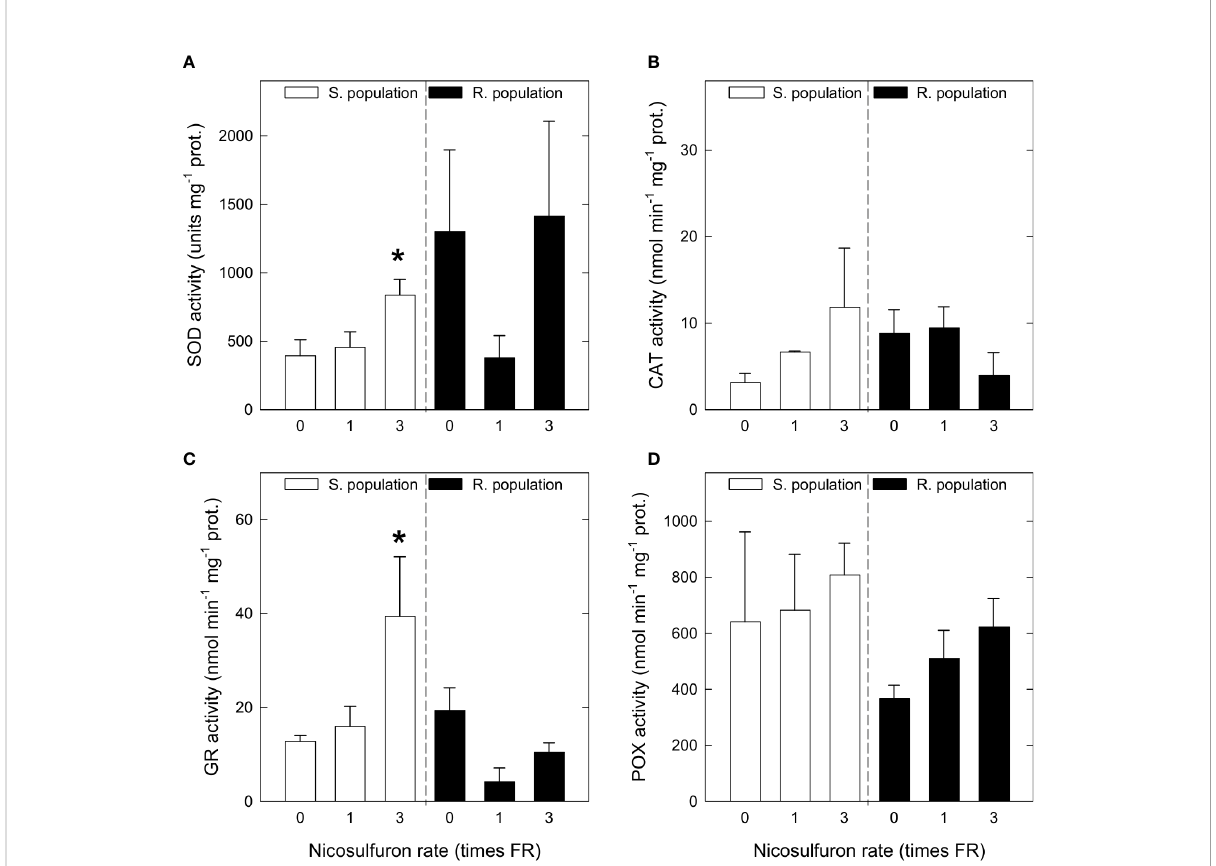
FIGURE 4 Superoxide dismutase (SOD) activity (A) , catalase (CAT) activity (B) , glutathione reductase (GR) activity (C) and peroxidases (POX) activity (D) in Amaranthus palmeri sensitive (S, white) and resistant (R, black) populations treated with different nicosulfuron rates (X axis, times recommended fi eld rate or FR, FR = 0.06 kg ha -1 ). Mean ± SE (n = 4). For each population, signi fi cant differences between treatments and their respective untreated are highlighted with asterisks (Student ’ s t-test, p value ≤